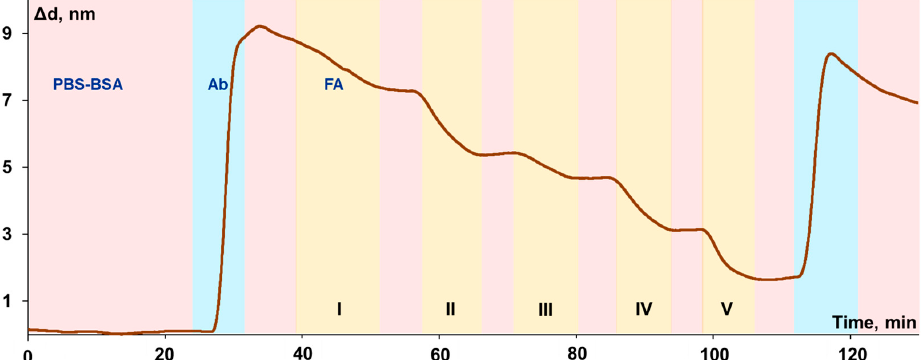
in the solution: I—2.2 pM, II—22 pM, III—226 pM, IV—2200 pM, and V—22,000 pM. Step VI